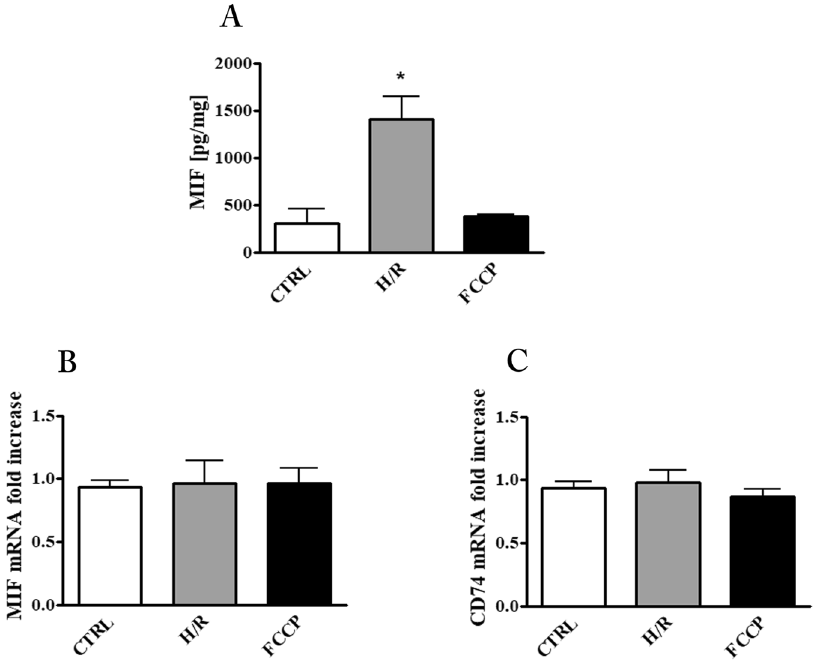
Figure 2. MIF and CD74 in placental explant cultures after exposure to hypoxia/re-oxygenation (H/R) and FCCP. ( A ) MIF concentration in culture supernatants quantified by ELISA assay and expressed as pg/mg (means ± SEM) of total explant tissue proteins. MIF ( B ) and CD74 ( C ) mRNA expression level assessed by qRT- PCR analysis. Results were normalized to those of 18 S and expressed as fold increase relative to control cultures. * p < 0.05 (n = 3 placentae at 8–9 weeks). CTRL: control explant cultures ; H/R: explant cultures exposed to